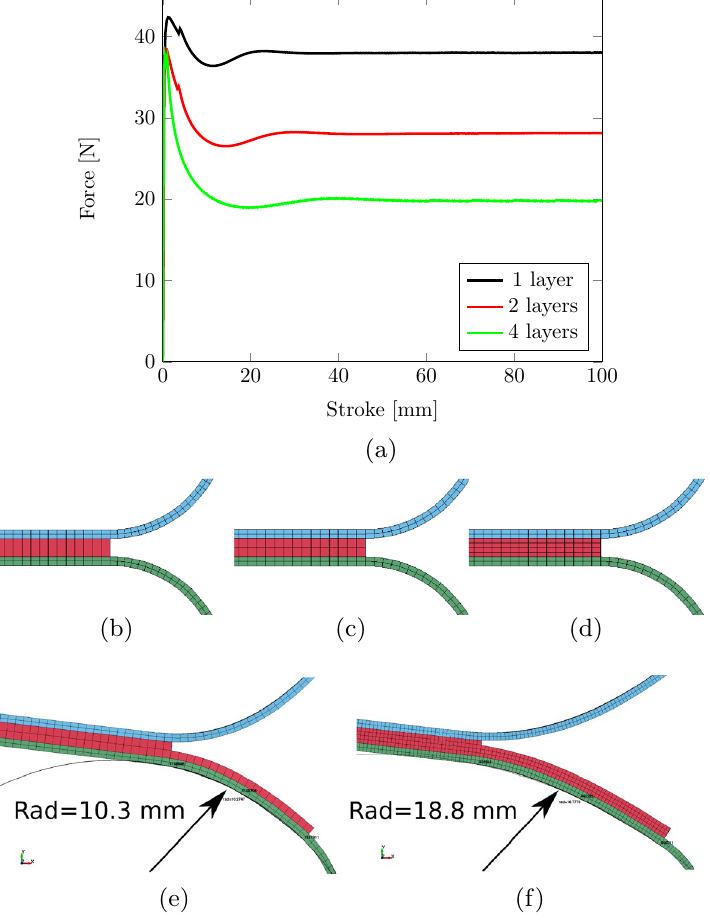
Fig. 13 a Contains the force– displacement responses obtained for the mesh densi- ties of the core. The three mesh densities are presented in b – d , where 1, 2 and 4 layers of solid elements has been used for the core, respectively. In e and f , the curvature of the skins are compared to illustrate the core’s contribution to stiffening the skins after